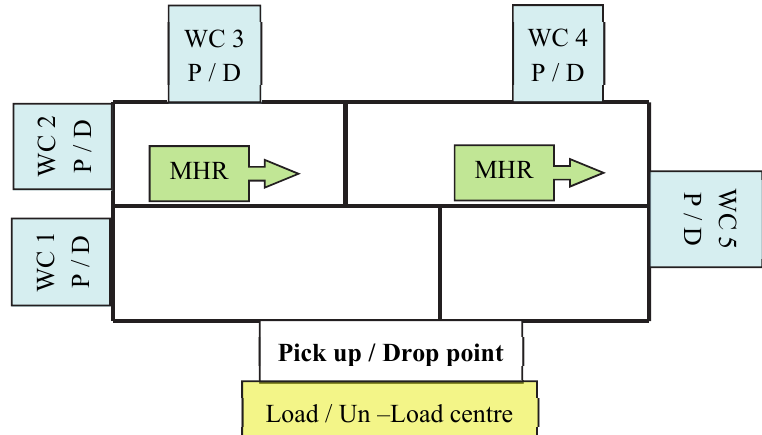
Fig. 2. The FMS layout 1 consisting of 5 work center and one load- unload